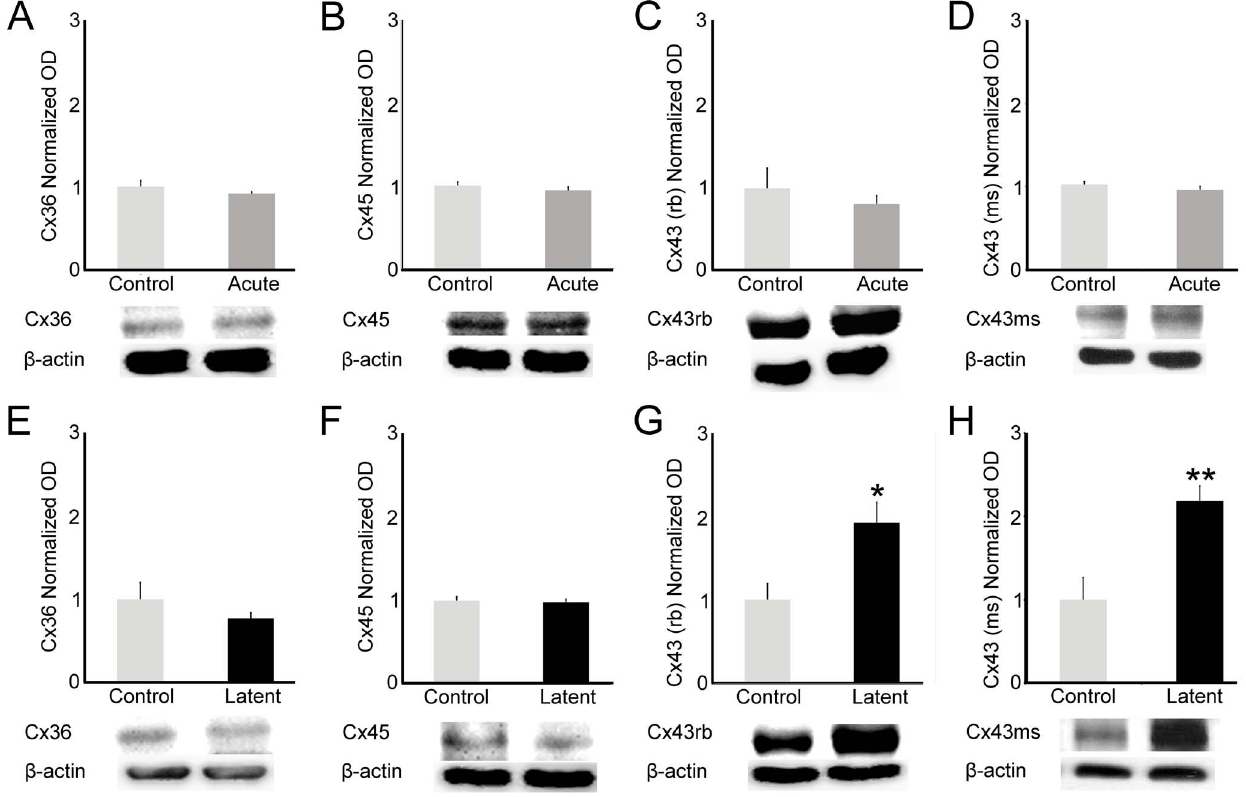
Figure 4. Quantification of Cxs protein levels in the hippocampus during acute and latent periods. (A–D) We observed stable steady levels of Cx36, Cx45, Cx43 protein levels during the acute period. (E–F) Similarly, analysis performed in the latent period showed steady state levels of Cx36 and Cx45 proteins. (G–H) In addition, we observed changes in both Cx43 total protein levels and Cx43 unphosphorylated form, which have higher levels in the latent group when compared to controls. Beta-actin (42 kDa) was used as internal control. Optical densities (OD) from acute (n=7) and latent (n=7) groups were normalized by OD from control (n=7) group in three independent experiments. Bars represent standard errors of mean. * P , 0.01; ** P , 0.001 in T-Test.